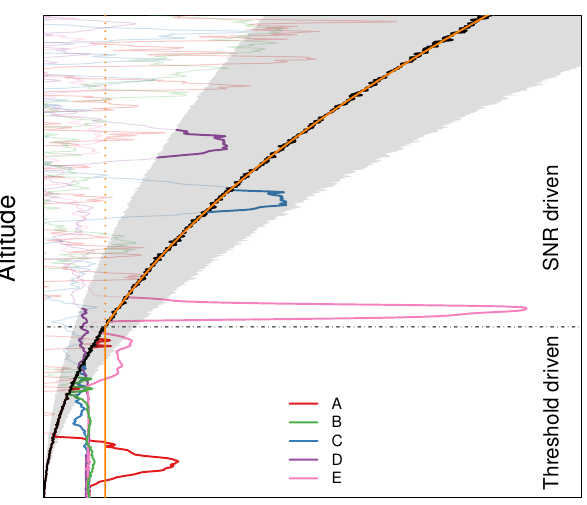
Fig. 4. Theoretical working of PT algorithm. The black curve in- dicates the average noise level, increasing with height. The solid orange curve indicates the detection method in function of range as used by the PT algorithm. Five example backscatter profiles are in- dicated by curves A to E. The horizontal dashed black line shows the altitude above which the detection method becomes SNR driven. The shaded area represents variable detection sensitivity based on the SNR